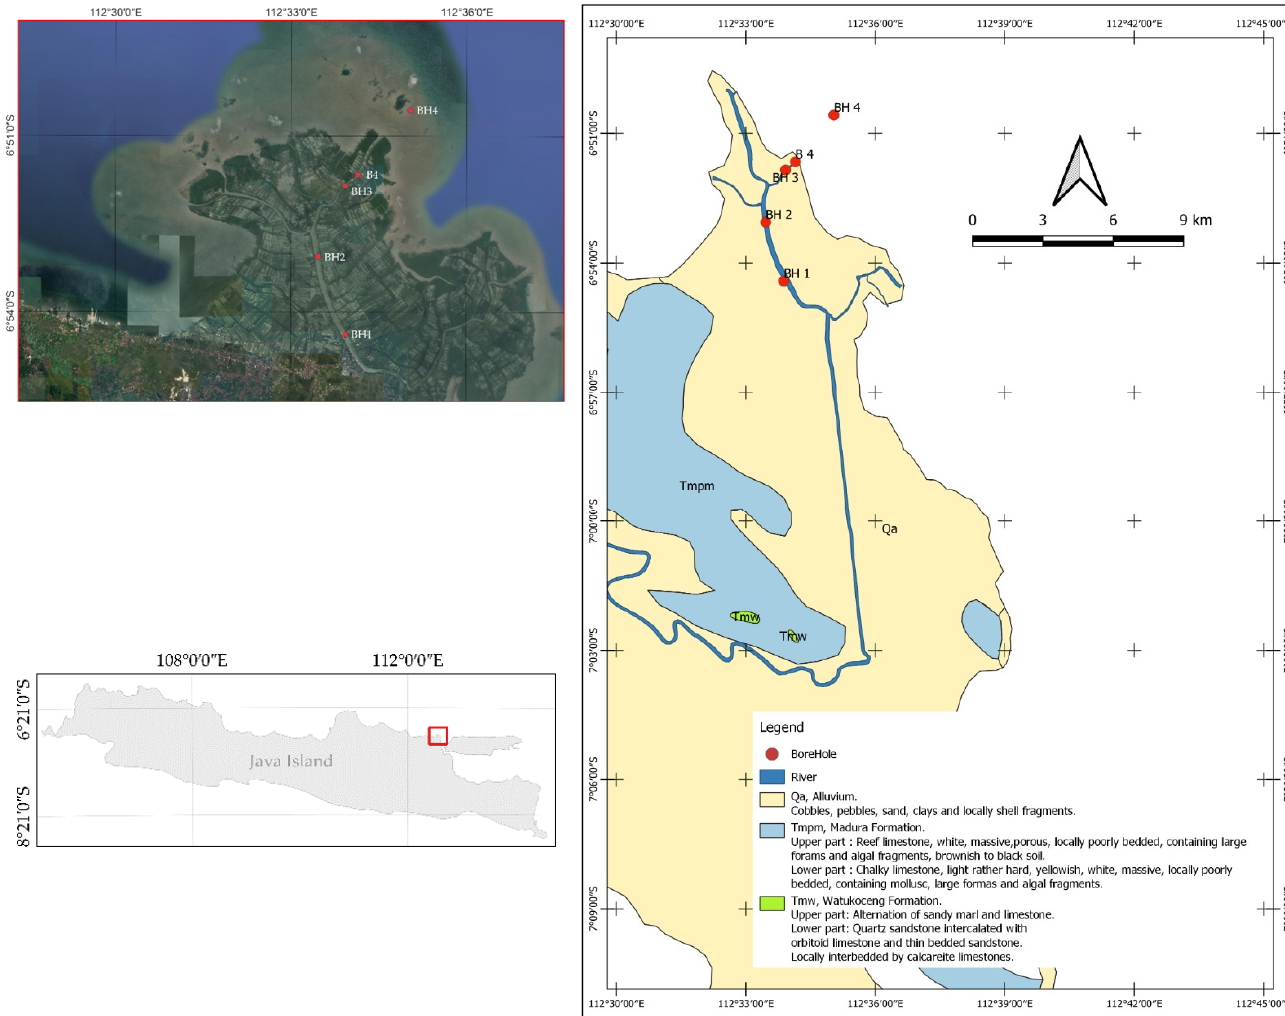
Figure 1. Geological map depicting the age of sediments. Site of borehole (BH) locations (BH1 was studied by Soemitro et al. (2020); BH2 and BH3 were studied by the authors with a different sampling method; BH4 followed the same sampling method as that for BH1). B4 was investigated to observe the sediment transport rate and involved BH3 due to its presence on the same channel (uniform flow).